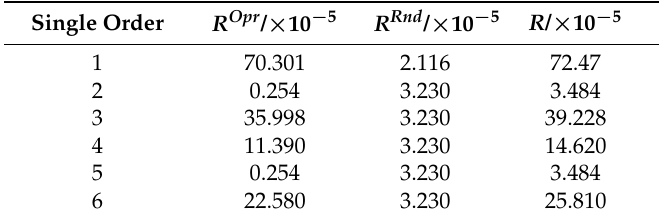
Table 7. Risk of the dispatching